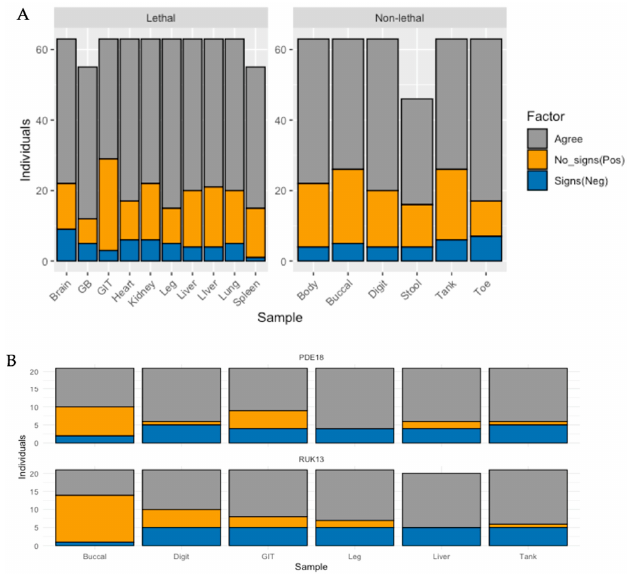
Figure 6. Bar plot illustrating the number of individuals for ( A ) frogs, and ( B ) toads that were; positive for ranavirus with each sample type in the absence of clinical signs (orange), the number of individuals negative for ranavirus by sample type in the presence of clinical signs (blue), and the number of individuals in which sample type agrees with absence/presence of clinical signs (grey). Ranavirus quantities in buccal swabs were consistently higher than other non-lethal sample types and either contained similar or higher quantities than the liver, kidney and GIT (Figure S2). Quantities of virus early on in infection were highest within buccal swabs, which, as infection progressed, remained consistently high. In comparison, virus in tissues began, on average, at lower levels, and increased to quantities similar or slightly higher than in the swab by the last sampling day (Table S11). 3.3. Ranavirus Shedding in R. temporaria Ranavirus was detected in 28/40 (70%) of stool samples and 37/63 (59%) of tank swabs. Similar to tissues, viral quantity increased significantly with increasing dose ( p < 0.01). The low dose treatment group had significantly lower viral quantities then the other treatment groups across all sampling days ( p < 0.05). Significant interactions, indicating further increases on later days at higher doses were detected in some combinations (Table S7). Ranavirus quantity (per PCR reaction) was substantially less in the stool and tank swabs compared to the gastro-intestinal tract ( p < 0.0001), liver and kidney ( p < 0.003) as infection progressed in the medium/high dose treatments (Figure 7).